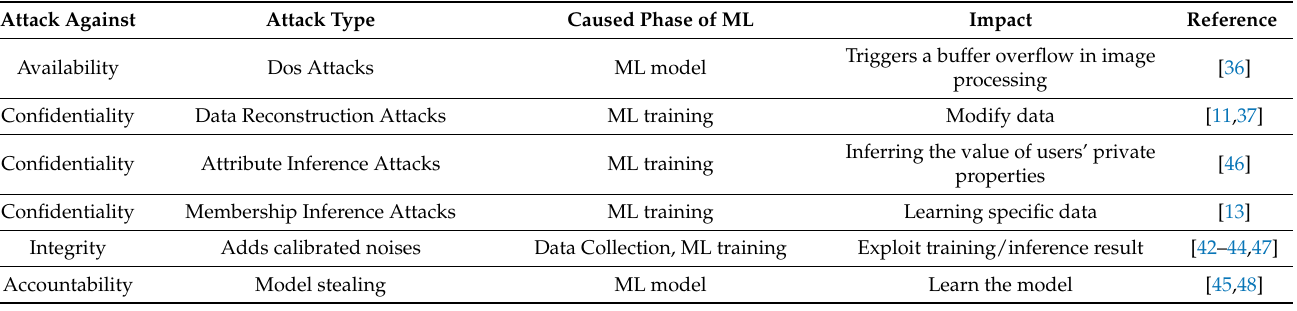
Table 8. Overview of security challenges in industrial machine learning